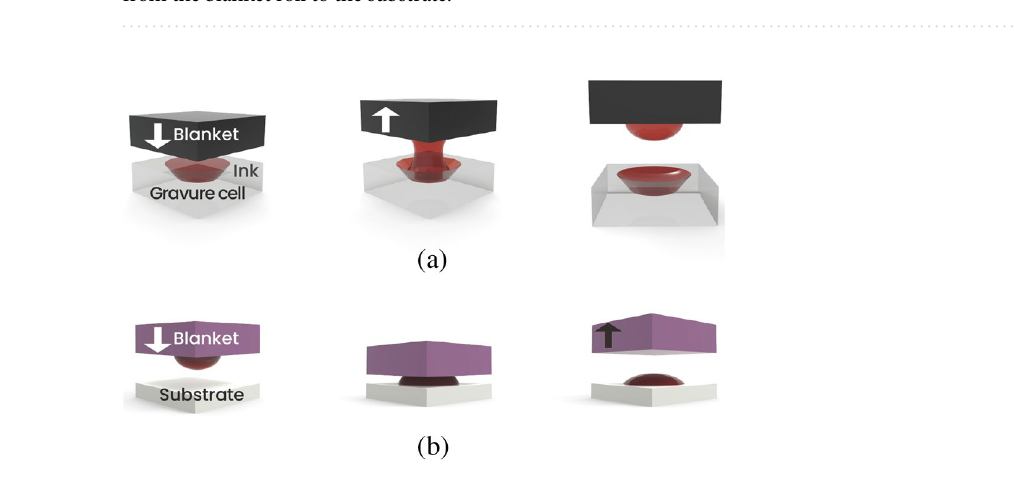
Figure 1. The gravure offset printing process: ( a , b ) ink filling the gravure plate and ( c ) ink doctoring, ( d , e , f ) off step when ink is transferred from the gravure plate to the blanket roll, ( g , h ) set step when ink is transferred from the blanket roll to the substrate.